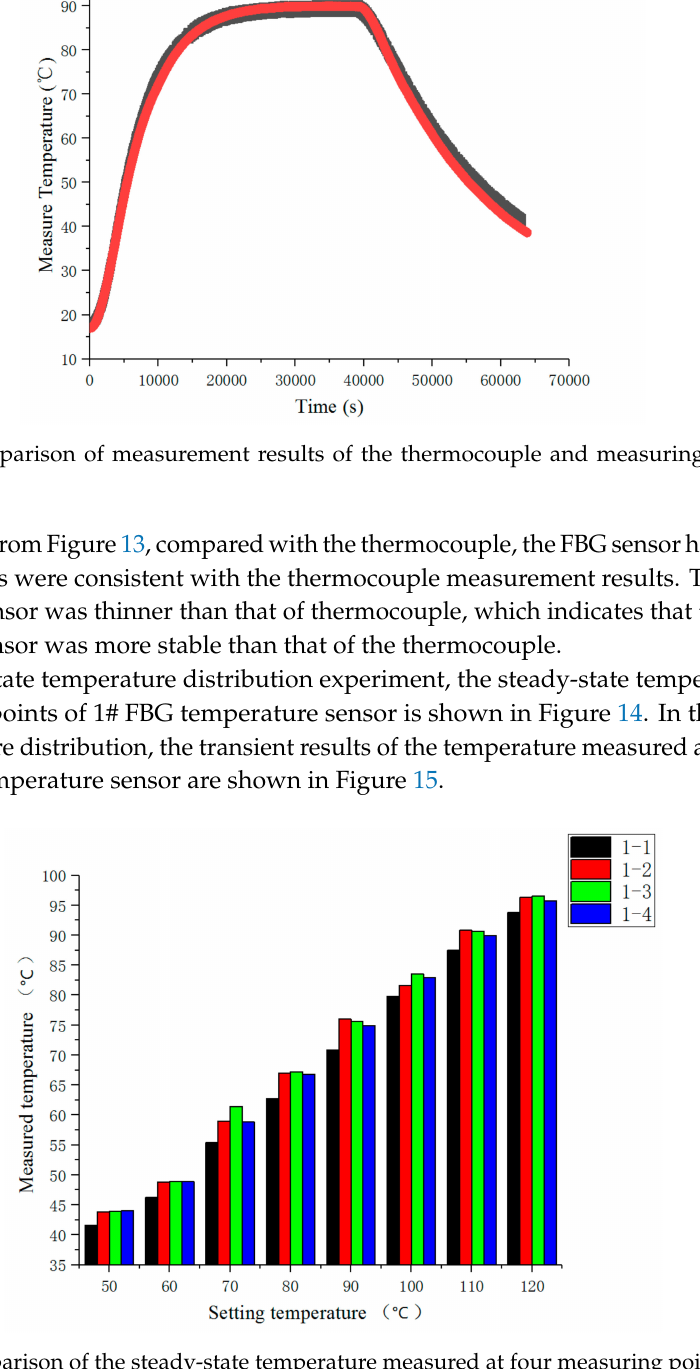
Figure 14. Comparison of the steady-state temperature measured at four measuring points of 1# FBG temperature